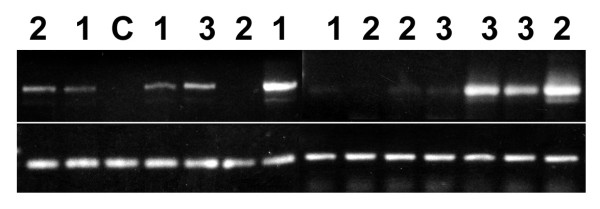
Smac/Diablo mRNA expression in cervical cancer patients. Upper panel: RT-PCR analysis of Smac/Diablo mRNA. To the left molecular weight marker (100 bp ladder, Invitrogen). Clinical stage is showed at the top of the panel: C: control samples, 1, 2 and 3, clinical stages. Lower panel: RT-PCR of GAPDH, used as a load control.